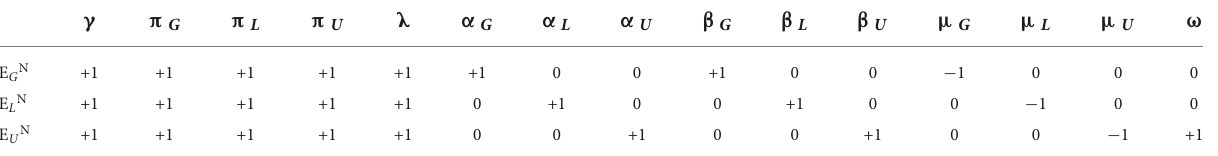
TABLE 2 The effects of the parameters on the optimal equilibrium strategies of the government, opinion leaders, and Internet users in centralized